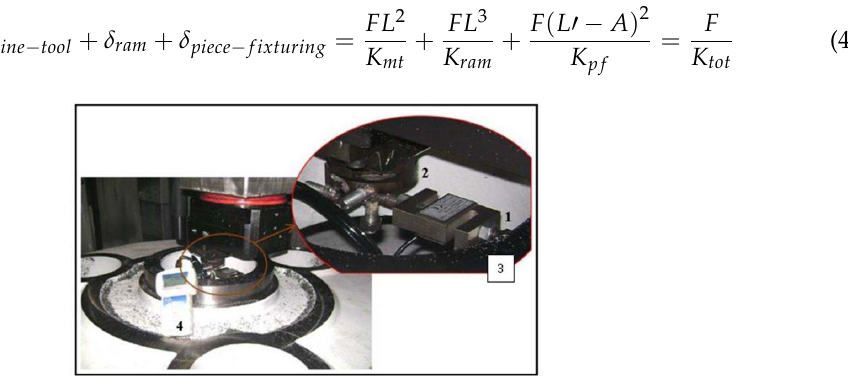
Figure 7. Stiffness measurement between the tool tip and a planet carrier. (1) Strain gauge; (2) Adapted design tool; (3) Part; (4) Strain indicator device.